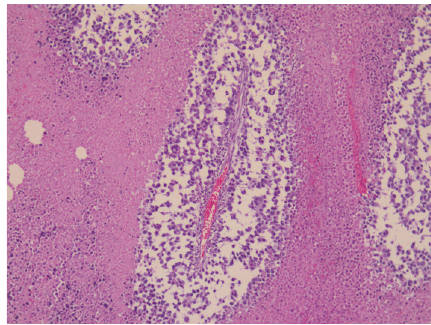
Figure12:Immunohistochemistryshowspositivecytoplasmic(dot- like) staining of the tumor cells for neurofilament (NF)